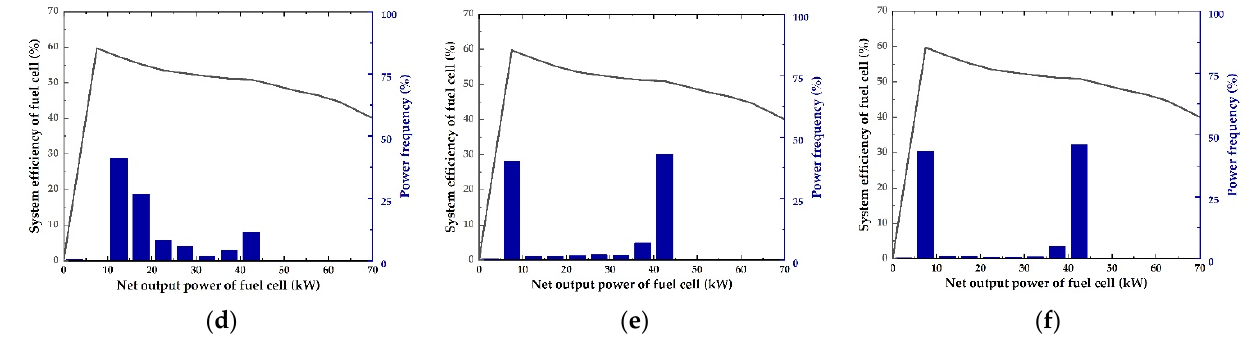
Figure 14. The efficiency distribution of the fuel cell with different strategies under CWTVC conditions. ( a ) Switch control strategy; ( b ) Sliding window filtering strategy; ( c ) Composite fuzzy strategy; ( d ) GA-fuzzy strategy; ( e ) PMP strategy; ( f ) P-PMP strategy.